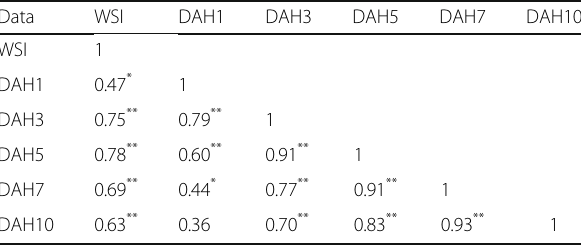
Table 2 Correlation coefficients between DAH and WSI